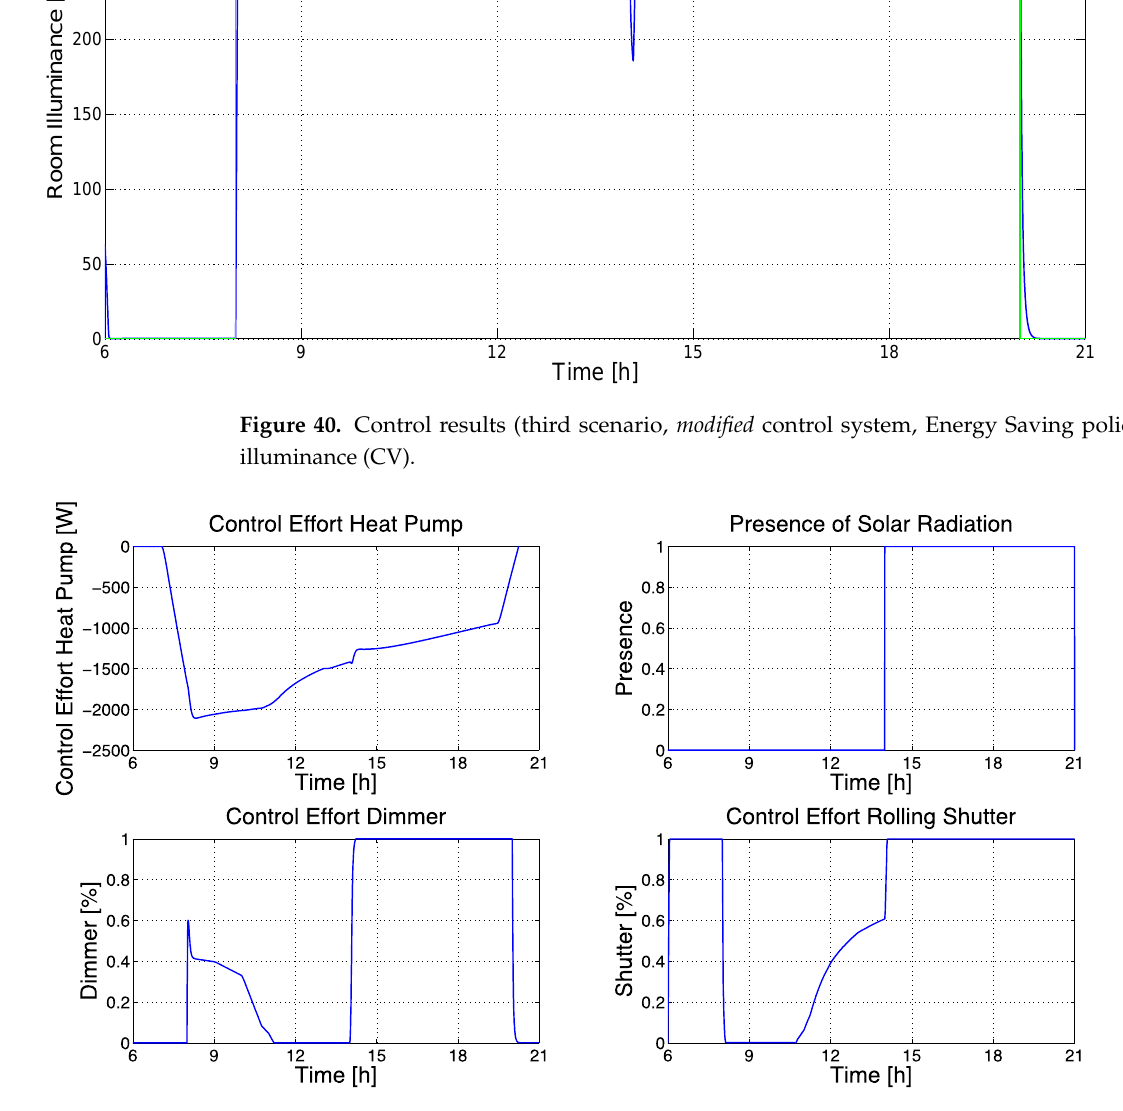
Figure 41. Control results (third scenario, modified control system, Energy Saving policy): MVs (heat pump, dimmer, and rolling shutters) and DV (presence of solar radiation).